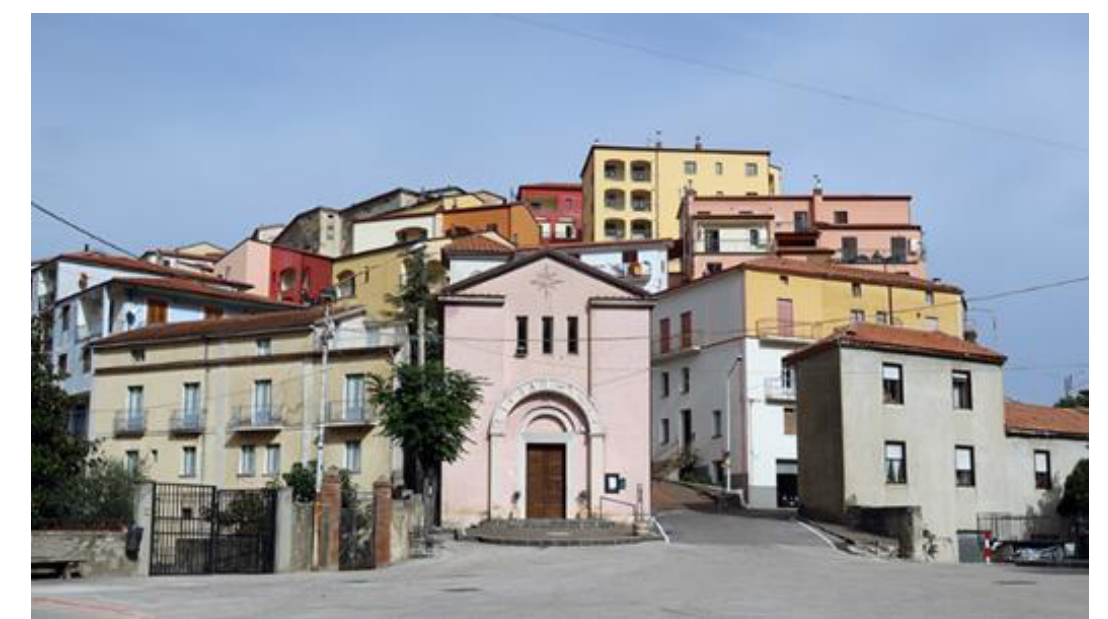
Figure 91. Salvitelle: the new Town Hall of the village (photos by [35,36]).